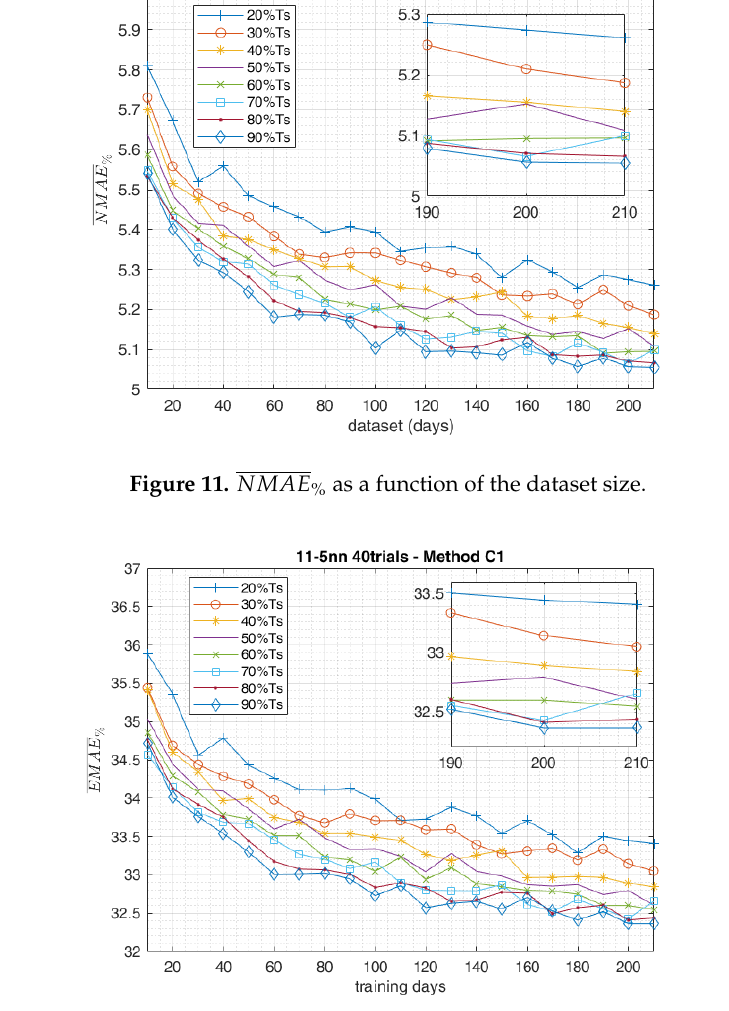
Figure 12. EMAE % as a function of the dataset